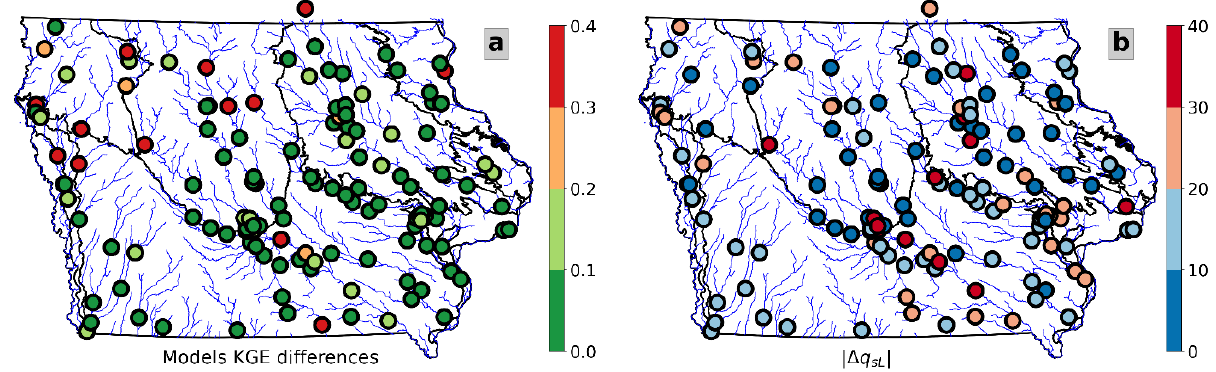
Figure 15. Maps showing KGE differences ( a ), and Δ𝑞 𝑠𝐿 ( b ), in USGS